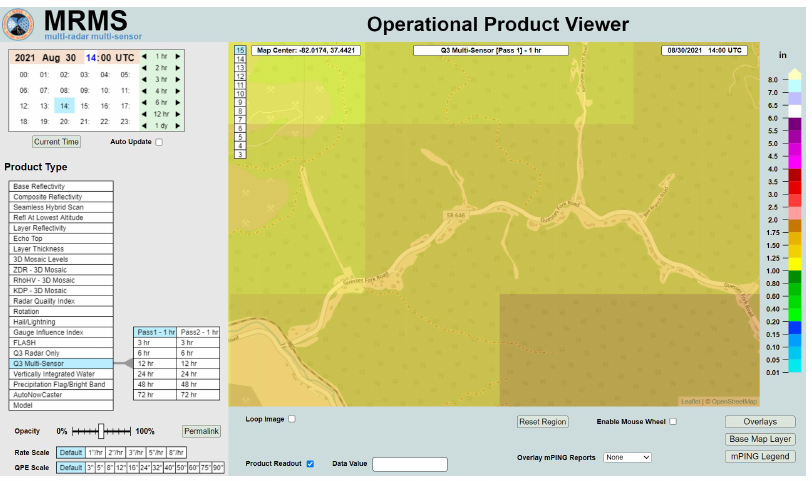
Figure 3. Example Multi − sensor Quantitative precipitation estimation data for the Guesses Fork Road area of Hurley, Virginia. The data is being displayed in the Operational Product Viewer